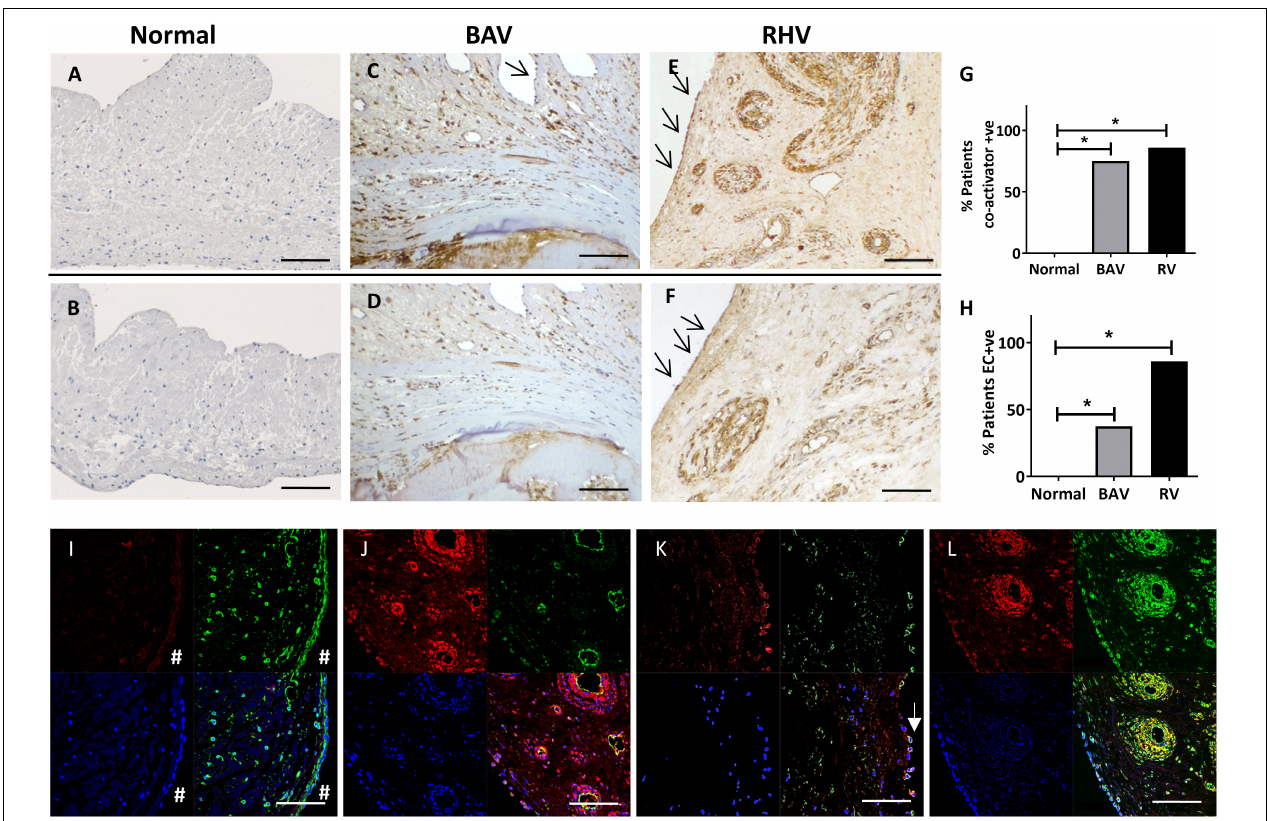
FIGURE 2 | The expression of co-activators myocardin (A,C,E) and MRTF-A (B,D,F) in normal, BAV and RHV cusps. Graph showing the incidence of BAV and RHD cusps positive for aberrant co-activator expression (G) and aberrant expression of co-activators in valve endothelial cells (VECs) (H) . Panels (I–L) show colocalization of markers in bottom right panels. No expression of myocardin (red) in a normal cusp in VICs or VECs ( # ), vimentin (green) present in both cell types (I) . RHV valve showing myocardin (red) in the endothelial cells and SM cells of their vasculature, (CD31, green) of the vessels and colocalisation in endothelial cells (J) . Some surface VECs of a BAV showing co-expression of myocardin (red) with CD31 (green) (K) . RHV showing myocardin (red) and SM-MHC (green) in SM of vasculature and some VICs (left side of vessels) (L) . Blue is DAPI staining. Scale bar represents 200 µ m. * p < 0.001.